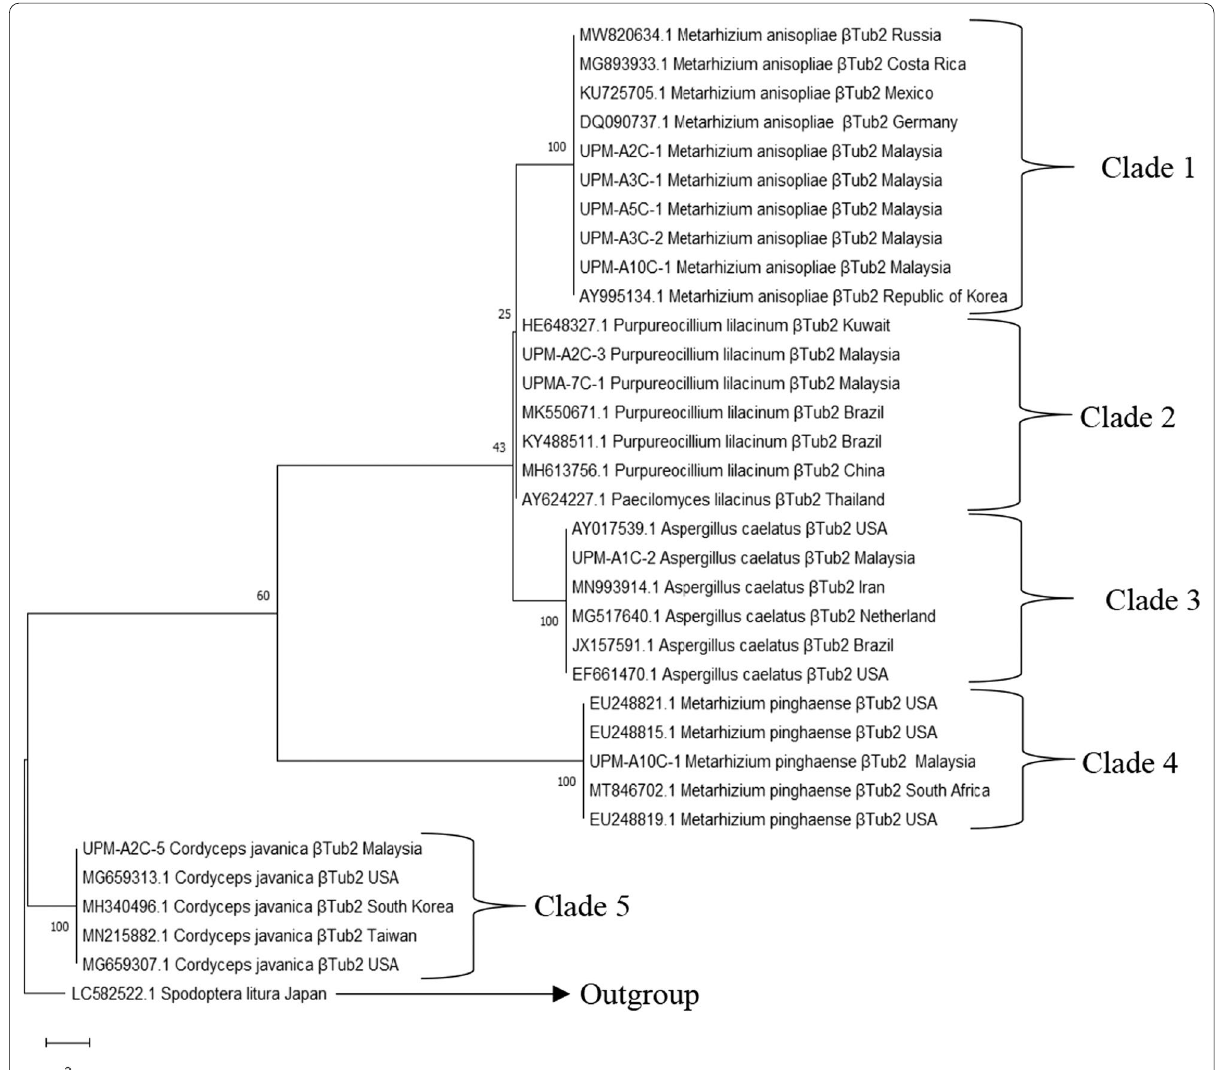
Fig. 4 Phylogenetic tree of βTub2 gene of EPF. Maximum Likelihood Tree generated based on the combined dataset of βTub2 nucleotide sequence of UPM EPF isolates developed using MEGA X. Only data with bootstrap value > 30% are shown. Models with the lowest BIC scores